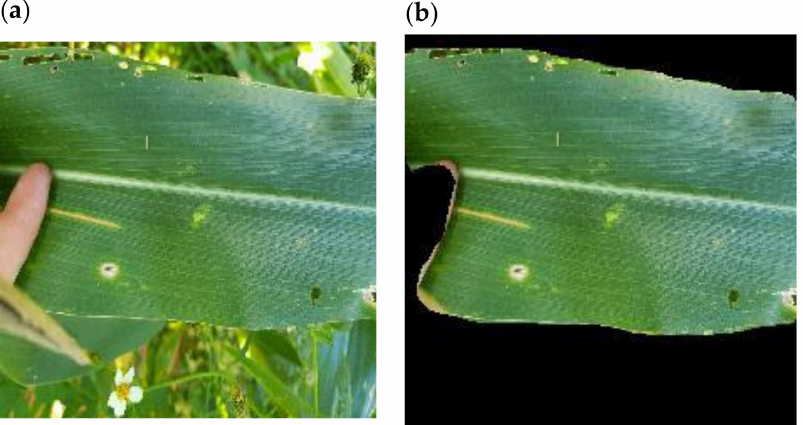
Figure 4. ( a ) Image of a maize leaf and ( b ) the same leaf after leafRCNN leaf area prediction and background